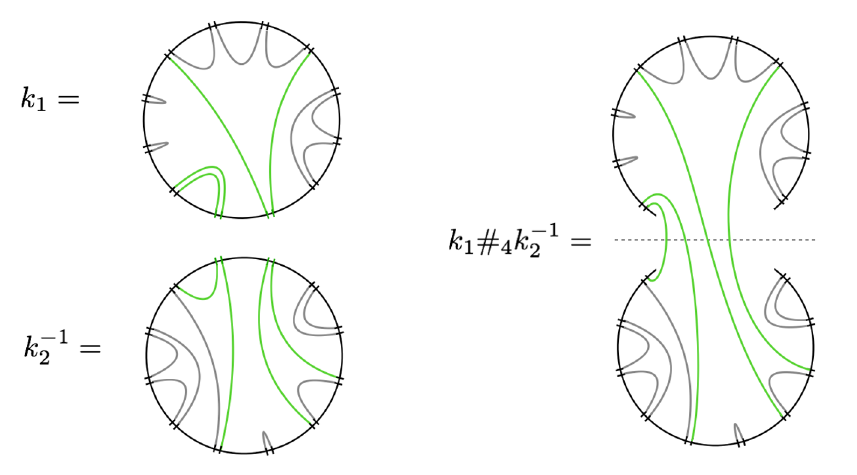
. The green lines represent the would-be 2